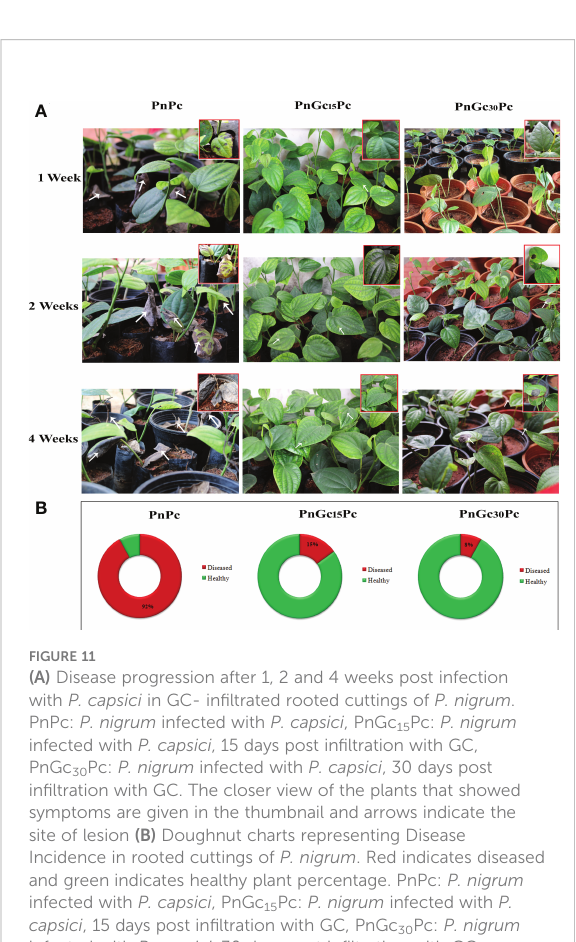
BA FIGURE 11 (A) Disease progression after 1, 2 and 4 weeks post infection with P. capsici in GC- in fi ltrated rooted cuttings of P. nigrum . PnPc: P. nigrum infected with P. capsici , PnGc 15 Pc: P. nigrum infected with P. capsici , 15 days post in fi ltration with GC, PnGc 30 Pc: P. nigrum infected with P. capsici , 30 days post in fi ltration with GC. The closer view of the plants that showed symptoms are given in the thumbnail and arrows indicate the site of lesion (B) Doughnut charts representing Disease Incidence in rooted cuttings of P. nigrum . Red indicates diseased and green indicates healthy plant percentage. PnPc: P. nigrum infected with P. capsici , PnGc 15 Pc: P. nigrum infected with P. capsici , 15 days post in fi ltration with GC, PnGc 30 Pc: P. nigrum infected with P. capsici , 30 days post in fi ltration with